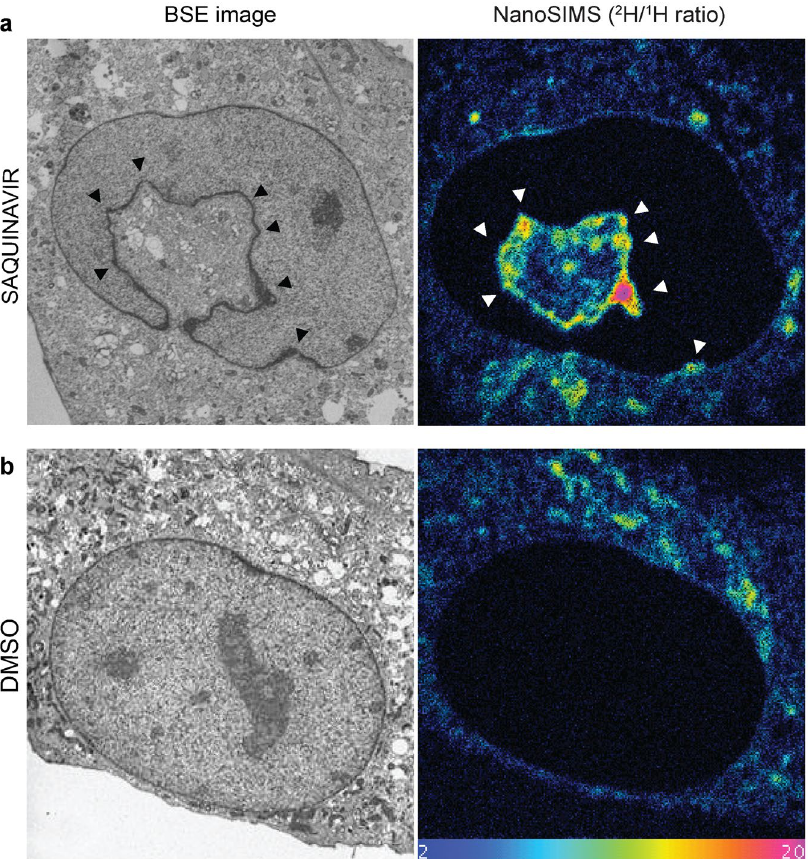
Figure 5. Detection of nascent phospholipids by pulse labelling with deuterated choline during NR formation. ( a ) Representative backscattered electron (BSE) image of a saquinavir-treated mouse preadipocyte (black arrowheads point towards high membrane curvature indicating NR initiation sites) with a corresponding image from NanoSIMS showing enrichment of deuterium signal ( 2 H/ 1 H ratio) revealing nascent phospholipids incorporated directly into forming NR (white arrowheads). ( b ) BSE and NanoSIMS images of a control cell treated with DMSO vehicle showing lack of NR tubules and no deuterium enrichment within the nucleus, and undistorted nuclear boundary. Colour scale of NanoSIMS images 2–20 equals 0.02–0.2% of 2 H/ 1 H